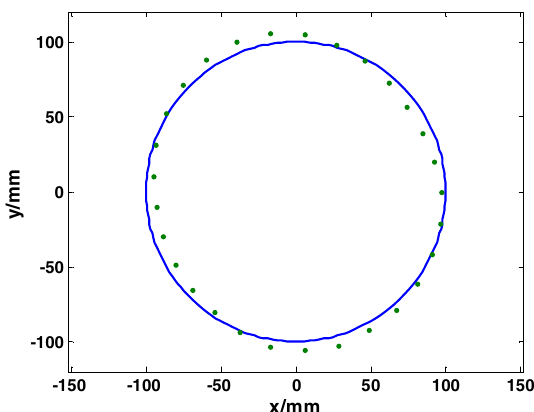
Fig. 4. Null space data generation for a least squares circle fit, with pre-assigned space correlation associated with the form